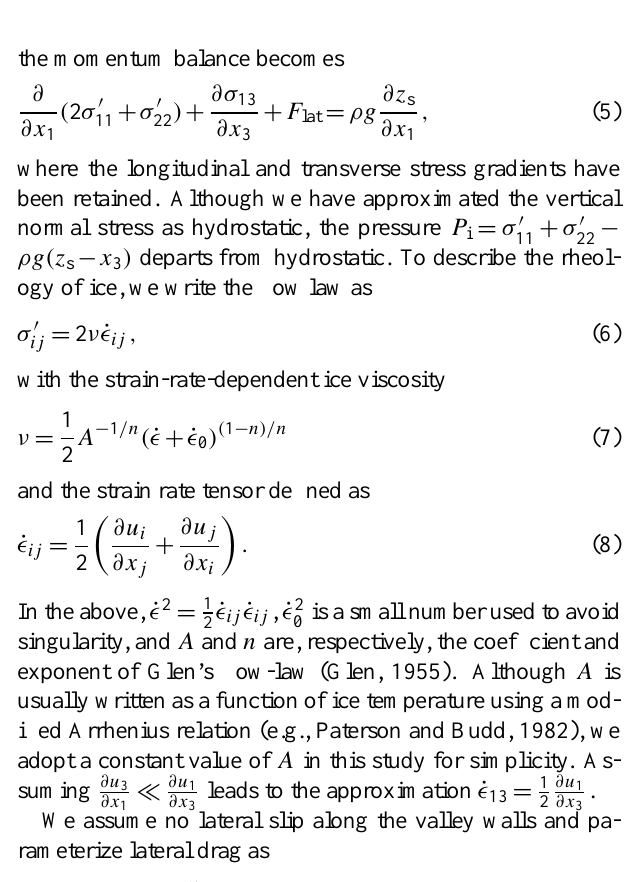
Fig. 2. Glacier bed topography and flowline geometry. (a) Glacier bed elevation as determined by ice-penetrating radar, with automatically generated flowlines (black = reference, grey = alternative). Unshaded tributaries have not been surveyed. (b) Glacier surface and bed topography along reference (black) and alternative (grey) flowlines as shown in (a) . Dotted line shows a synthetic bed profile that omits the overdeepening and bedrock ridge. (c) Glacier width along flowlines. Note that width profiles exclude tributaries.